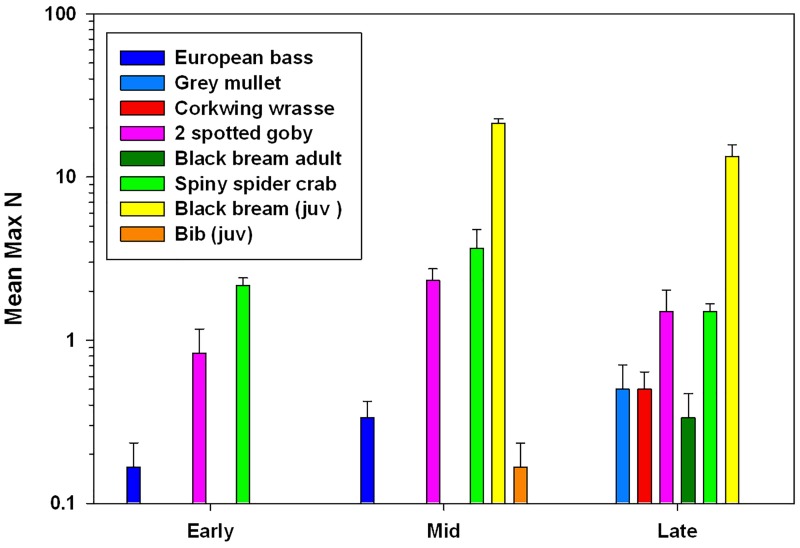
Mean abundance of species pairs of Pelagic adults (European bass, Grey mullet, Territorial adults (Corkwing wrasse, 2-spotted goby, Migratory (Black bream and Spiny spider crab) and Juvenile (Black bream and bib) in early, mid and late summer 2013.Data collected from BRUV surveys. Error bars show SE.